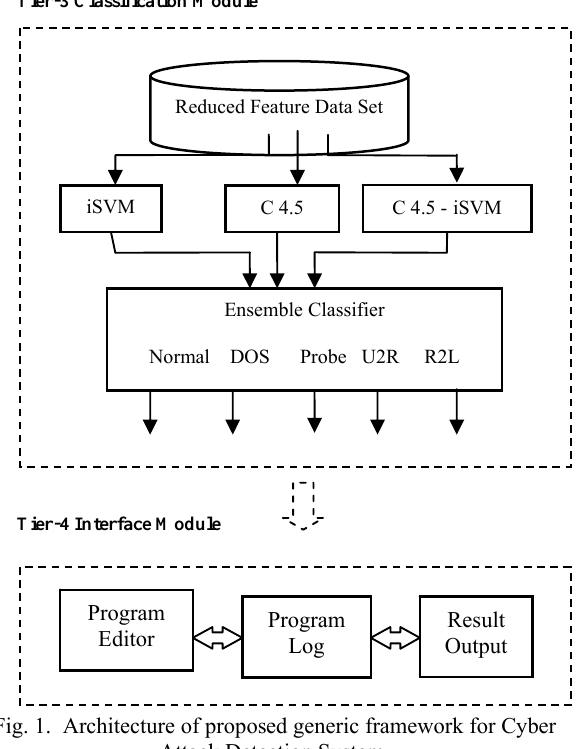
Fig. 1. Architecture of proposed generic framework for Cyber Attack Detection